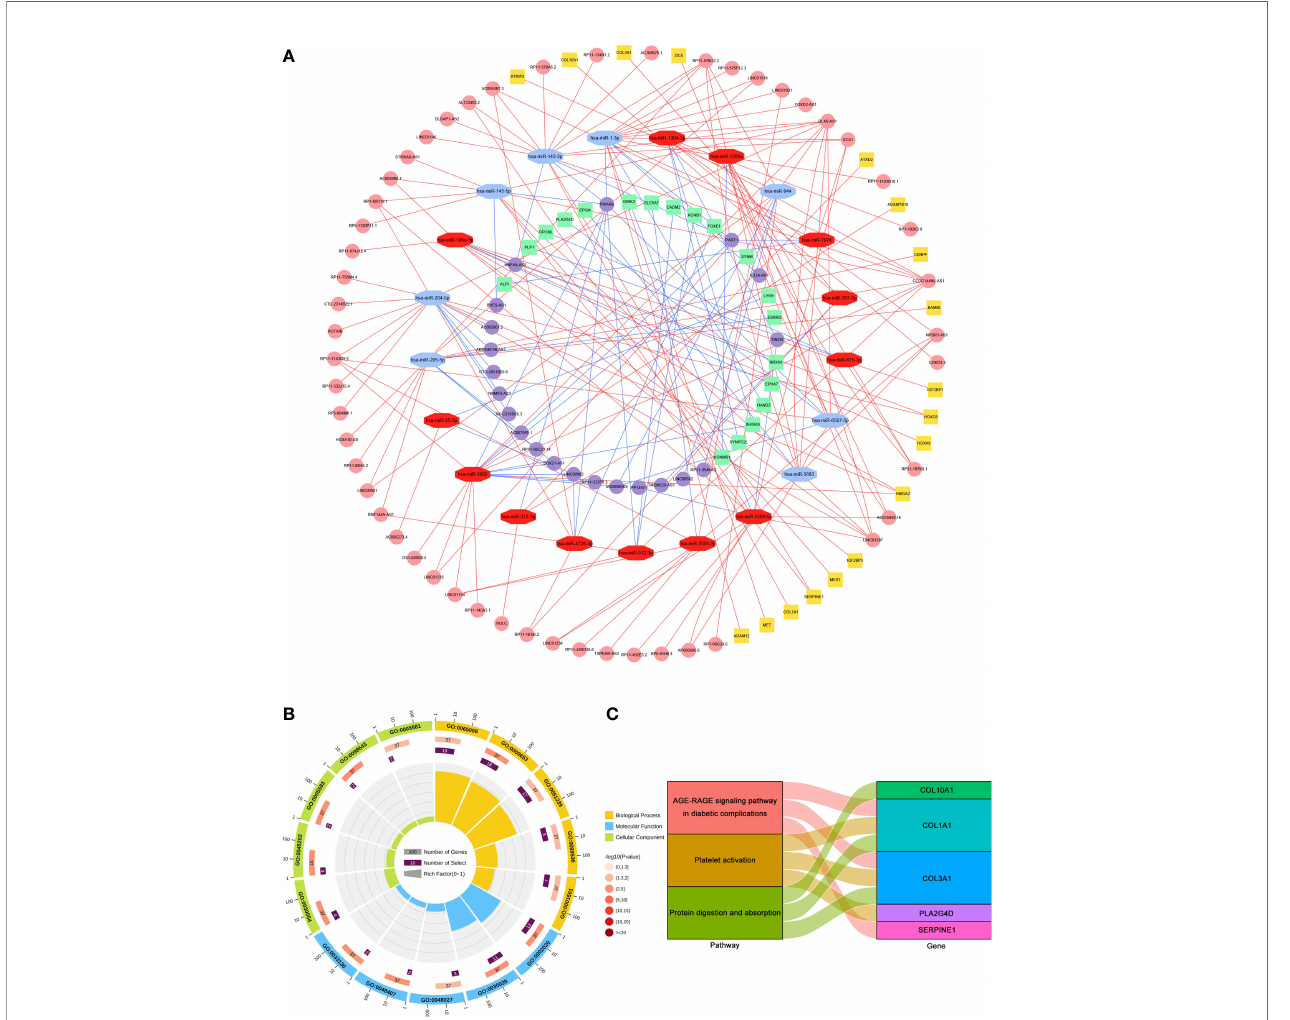
FIGURE 2 | Construction and functional enrichment analysis of the lncRNA-miRNA-mRNA triple regulatory network. (A) The triple regulatory network in STAD. Red octagons represent upregulated miRNAs, and blue octagons represent downregulated miRNAs. Pink circles and yellow squares stand for upregulated mRNAs and lncRNAs, respectively. Purple circles and green squares present downregulated mRNAs and lncRNAs, respectively. (B) Circle diagram of the top 5 GO terms of BP, MF and CC. (C) Sankey plot of KEGG pathways analysis for the network. Rectangles on the left of the Sankey plot represent the signi fi cant pathways, while rectangles on the right represent DEmRNAs in the